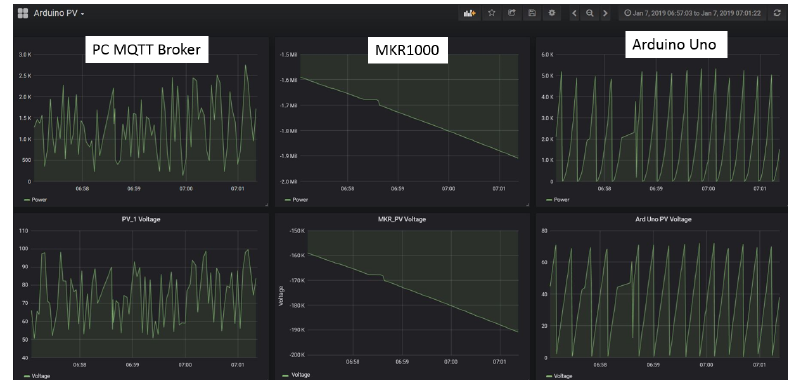
Figure 13. The data visualization of PC MQTT Broker, MKR1000 and Arduino Uno through Grafana